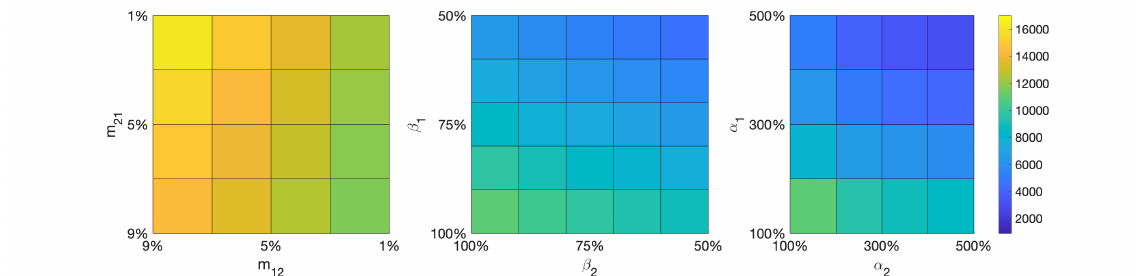
Figure 11. The impacts of three different patch-specific interventions on cumulative incidence are shown; the leftmost panel of travel restriction, the middle panel of social distancing, the rightmost panel of early detection rate (measured at day